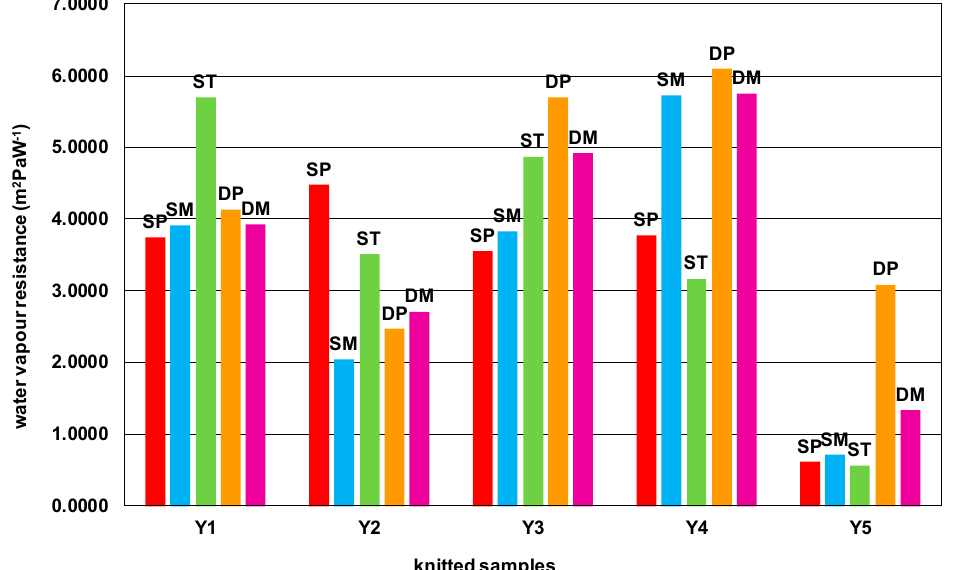
Figure 3. Water vapour resistance of knitted samples in different single and double structures.